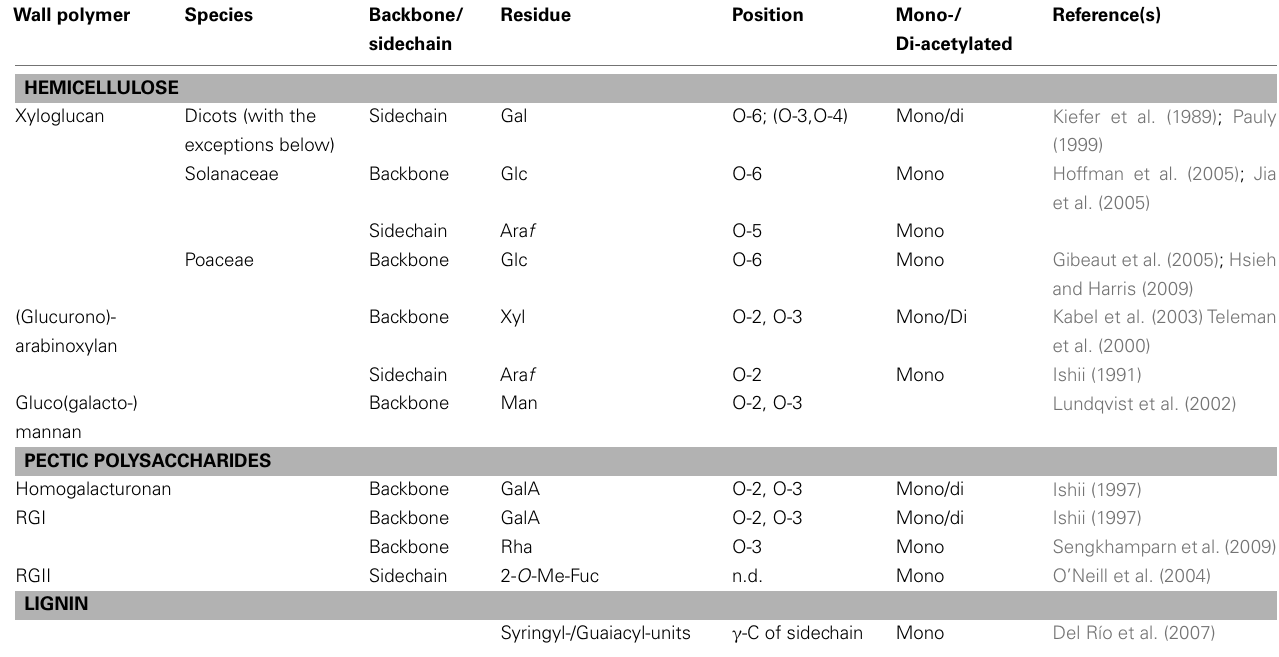
Table 1 | O -acetylated cell wall